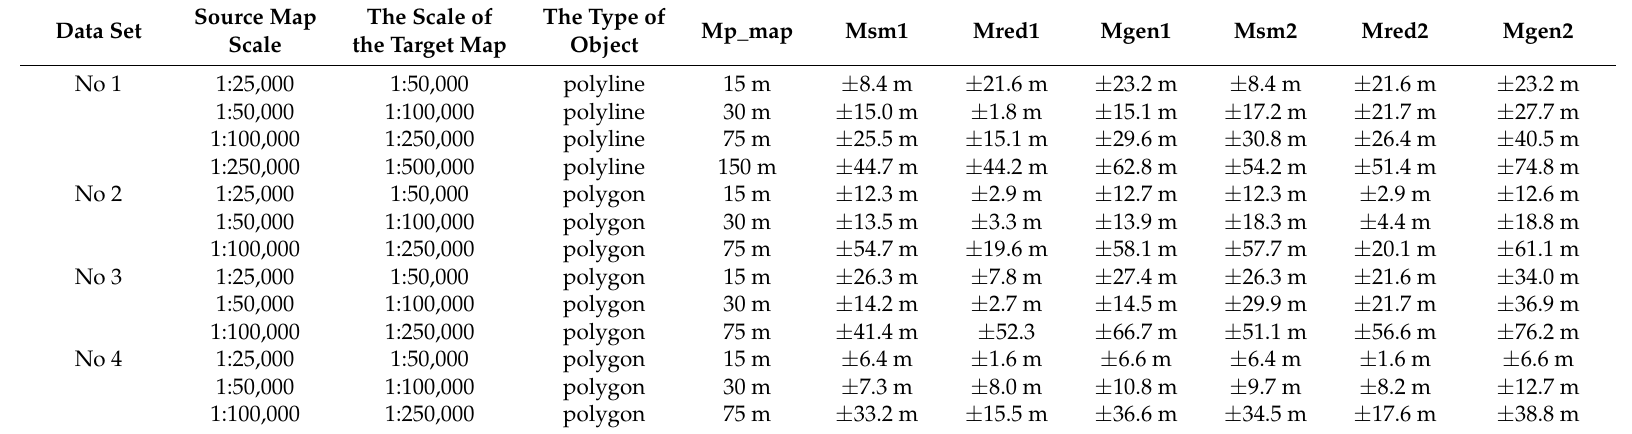
Table 2. List of mean errors of the position of points after